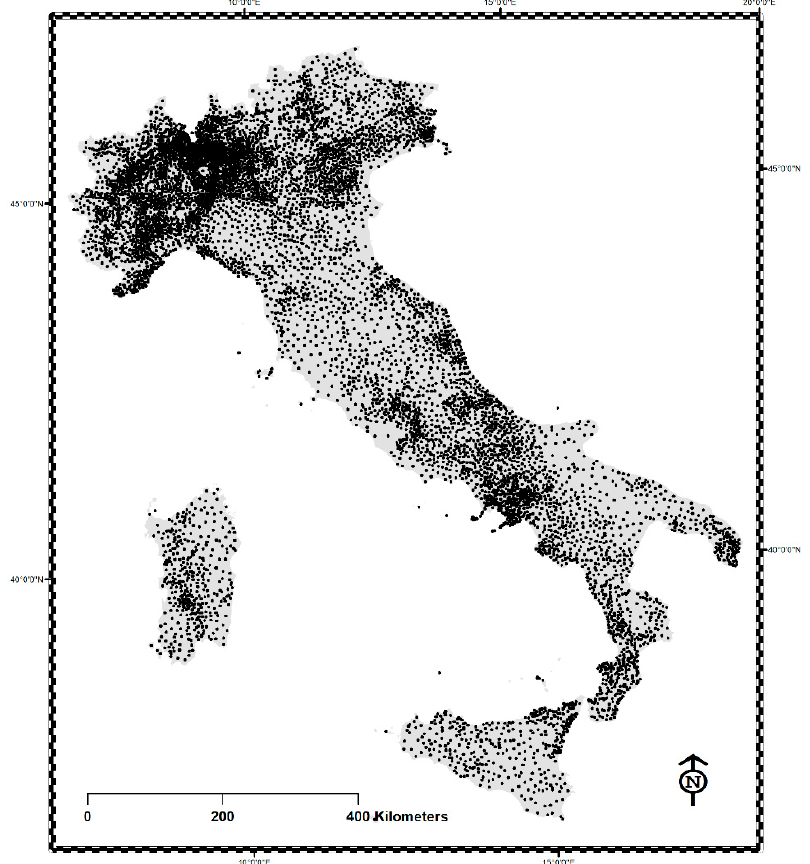
Figure 2. The centroids of the Italian municipalities. Each point corresponds to a different municipal planning